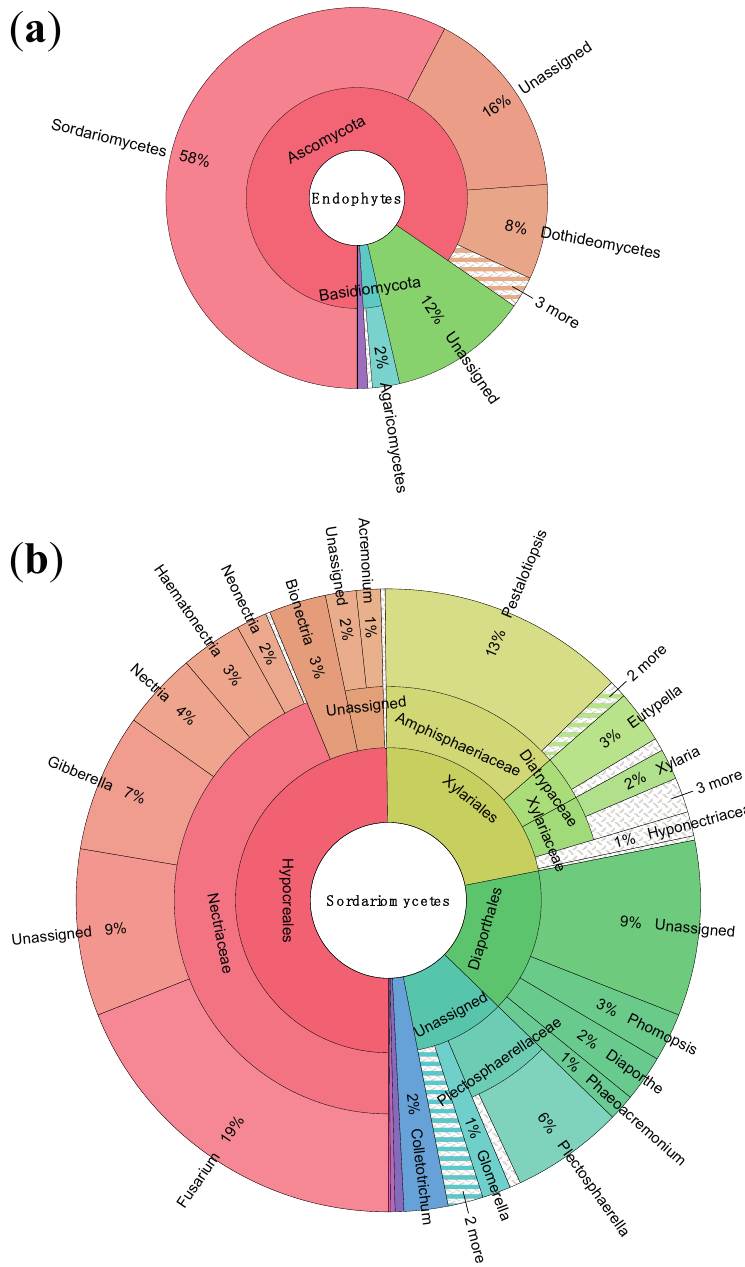
Figure 3. ( a ) Sunburst plot showing taxonomic abundance of 1526 sequences to order; ( b ) Taxonomic abundances within the most abundant order, Sordariomycetes, to genus. Visualized using Krona hierarchical data browser